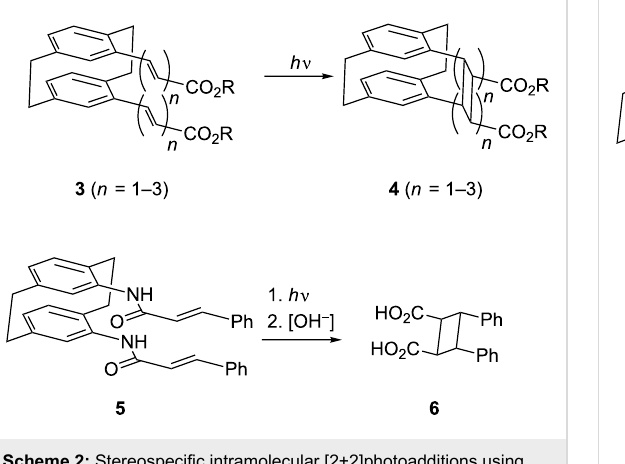
Scheme 2: Stereospecific intramolecular [2+2]photoadditions using [2.2]paracyclophane spacers.